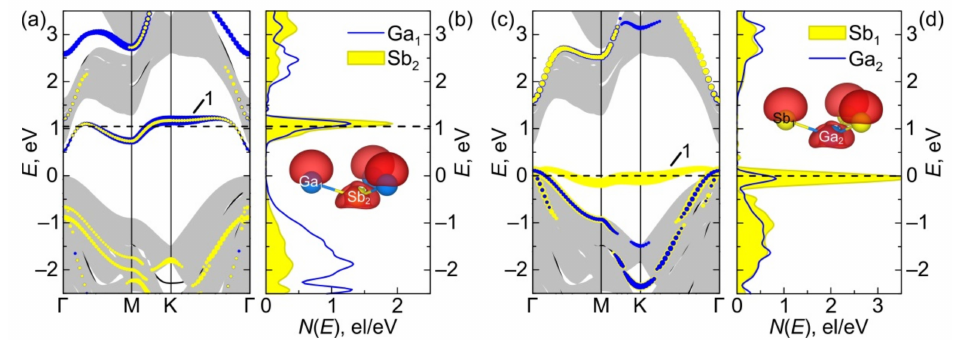
Figure 3. Electron energy spectra of the GaSb(111)A ( a ) and GaSb(111)B ( c ) surfaces; local density of states for surface atoms and partial charge densities (in the inserts) corresponding to states near the Fermi level ( b , d ). The horizontal dashed line shows the Fermi level position in the film. The zero energy corresponds to the valence-band maximum in the projection of bulk states shown by gray color fill in ( a , c ). The surface states localized on surface and subsurface Ga (Sb) atoms in ( a , c ) are shown by blue (yellow) balls. The larger balls correspond to the higher localization